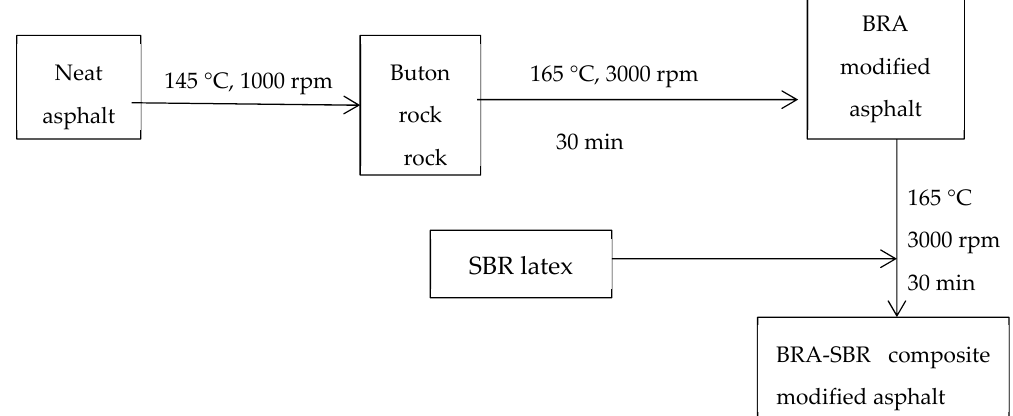
Figure 2. Flow chart for preparing modified asphalt. Table 4. Buton rock asphalt (BRA) and BRA ash content comparison table.